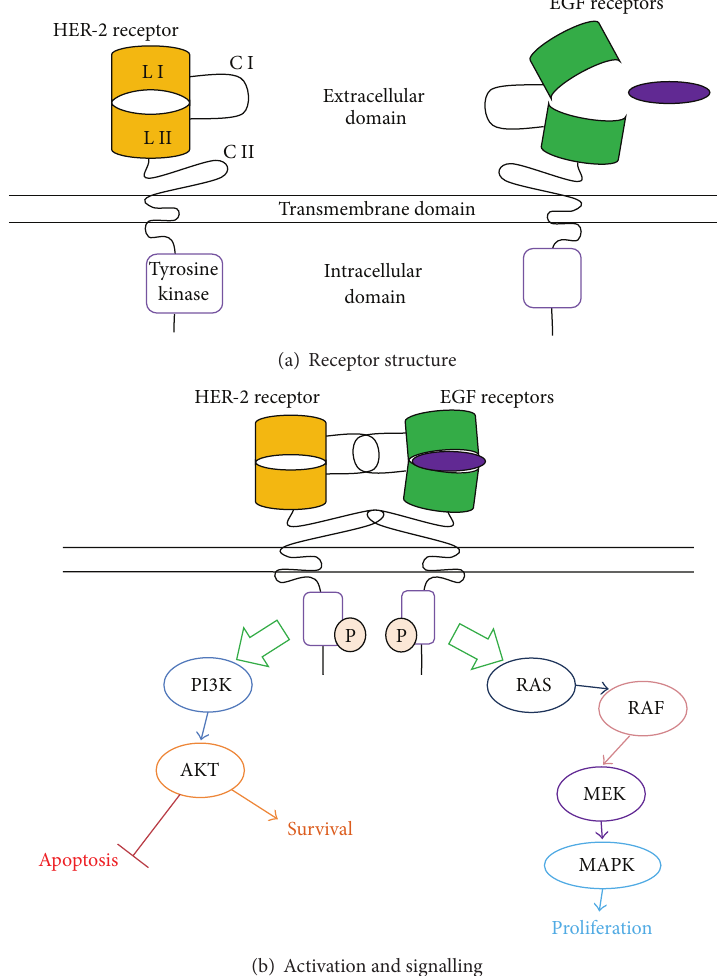
Figure 2: Schematic of HER-2 structure, activation, and signalling. (a) HER-2 is a single transmembrane cell surface receptor with extracellular, transmembrane, and intracellular regions. The extracellular region comprises of two ligand-binding domains (L I and L II) and two cysteine-rich domains (C I and C II) [8]. Intracellularly, HER-2 receptors have intrinsic tyrosine kinase activity (TK). (b) HER-2 does not bind ligands but is activated by forming heterodimers with other ErbB receptors via interaction at the cysteine-rich domains. This results in autophosphorylation of the tyrosine kinase domains and induction of downstream signalling. Normal signalling includes stimulation of the PI3K/AKT pathway which induces survival mechanisms and inhibits apoptosis, whilst the RAS/RAF/MEK/MAPK pathway stimulates cell proliferation